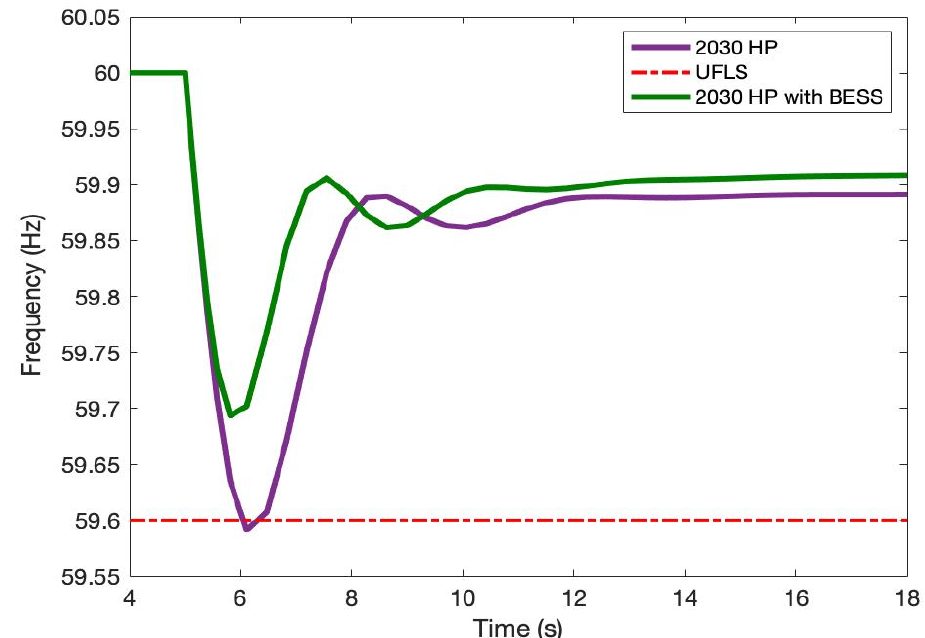
Figure 14. Frequency response following power disturbance in 2030 with BESS.